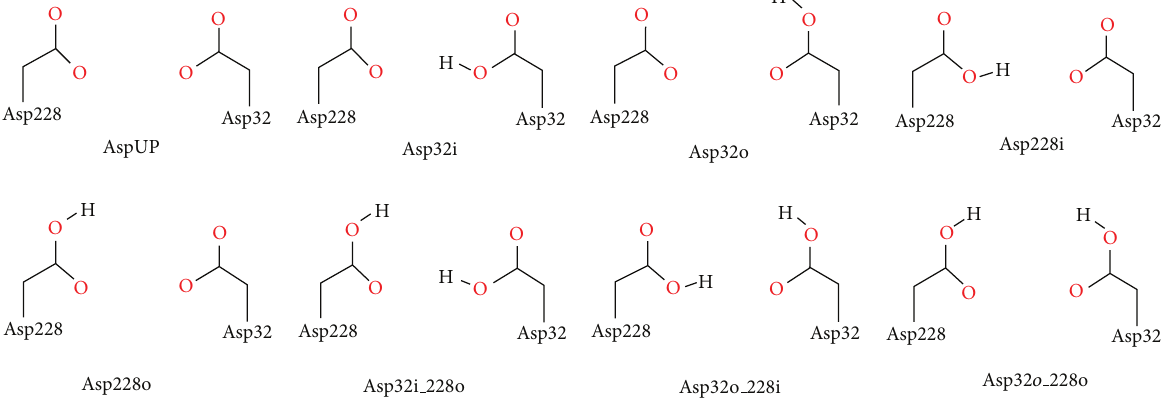
Figure 5: Possible protonation states of the two catalytic Asp residues.